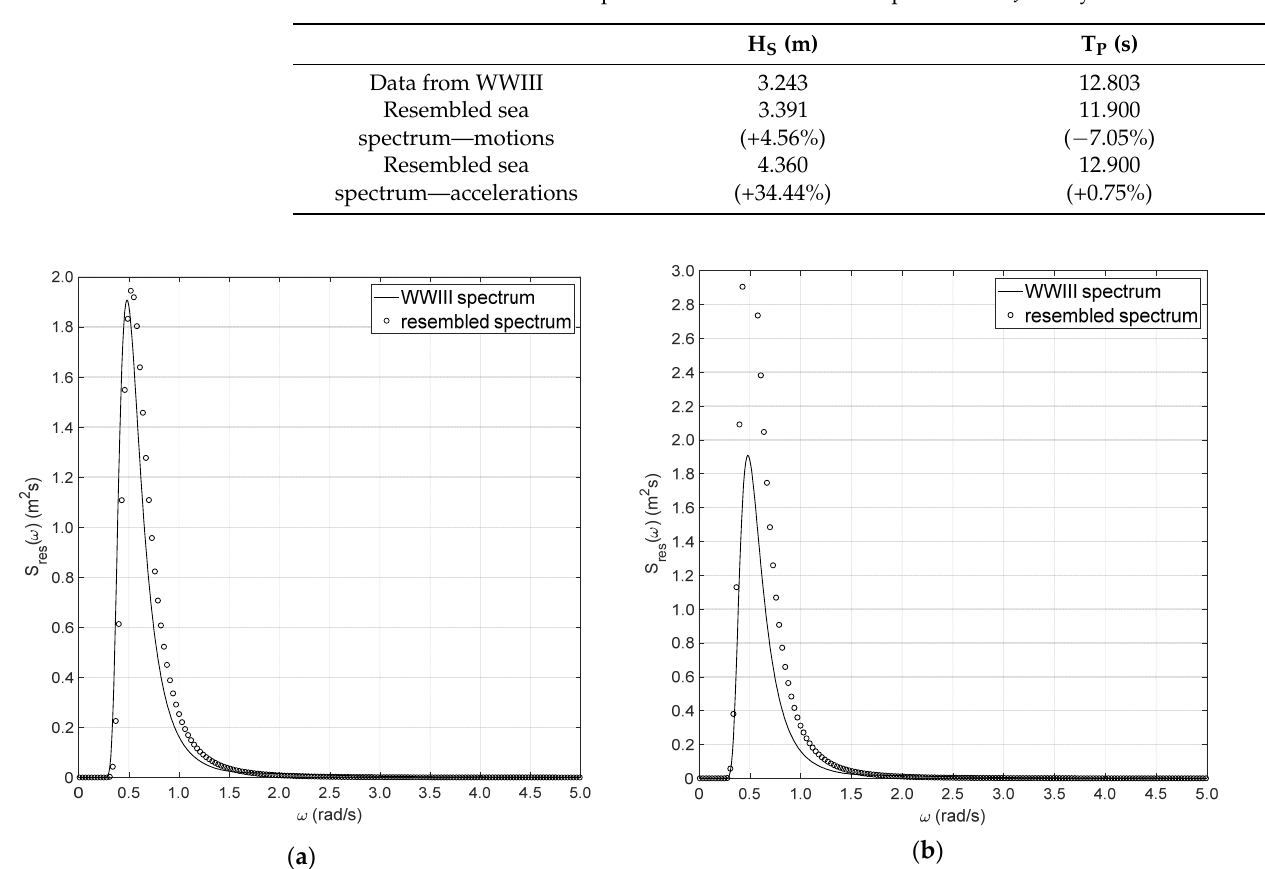
Figure 6. Sea spectrum—7 January 2020: ( a ) resembled combined sea spectrum using heave and pitch motions; ( b ) resembled combined sea spectrum using heave and pitch accelerations.